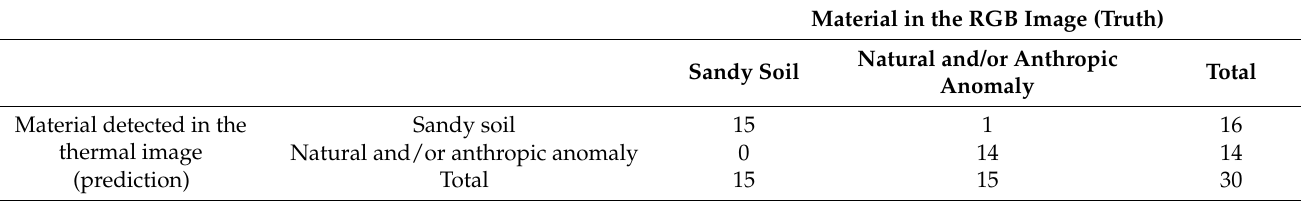
Material detected in the